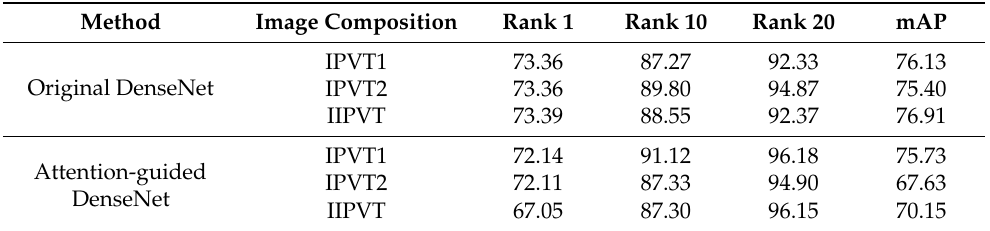
Table 3. Comparisons of ReID accuracies according to various input image compositions with DBPerson-Recog-DB1 (unit: